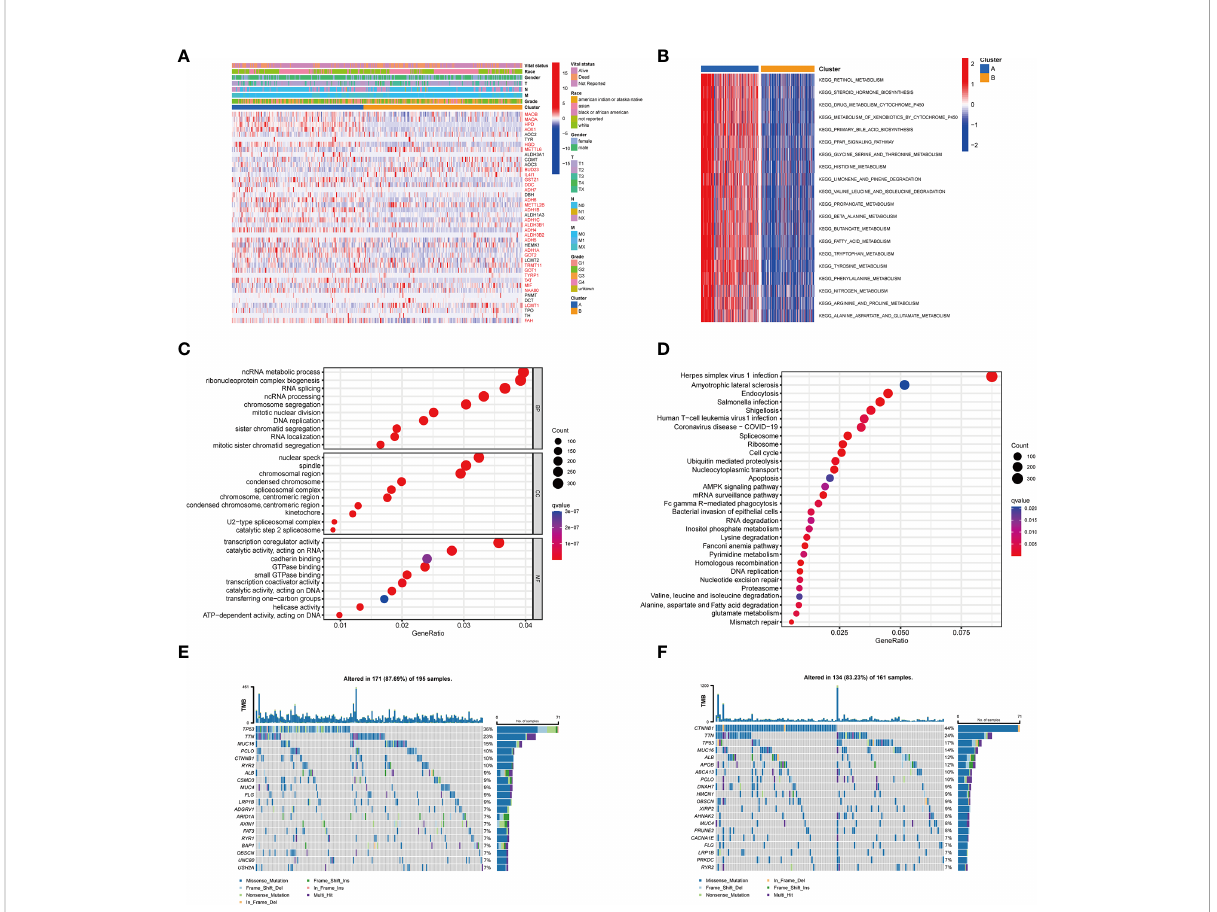
FIGURE 3 Clinicopathological features, enrichment analysis and mutation landscape of two TRGs clusters. (A) Differences in clinicopathologic characteristics and expression levels of TRGs between the two subtypes. (B) GSVA of biological pathways between two subtypes, in which blue inhibited and red represent activated pathways, respectively. (C) GO enrichment analysis shows the BP, CC, and MF of two TRGs subtypes. (D) The bubble plot depicted the KEGG pathway enrichment analysis of the two clusters. (E) Mutation landscape of TRGs cluster (A – F) Mutation landscape of TRGs cluster (B) GSVA, gene set variation analysis; GO, gene ontology; BP, biological process; CC, cellular component; MF, molecular function; KEGG, Kyoto Encyclopedia of Genes and Genomes; TRGs, tyrosine metabolism-related